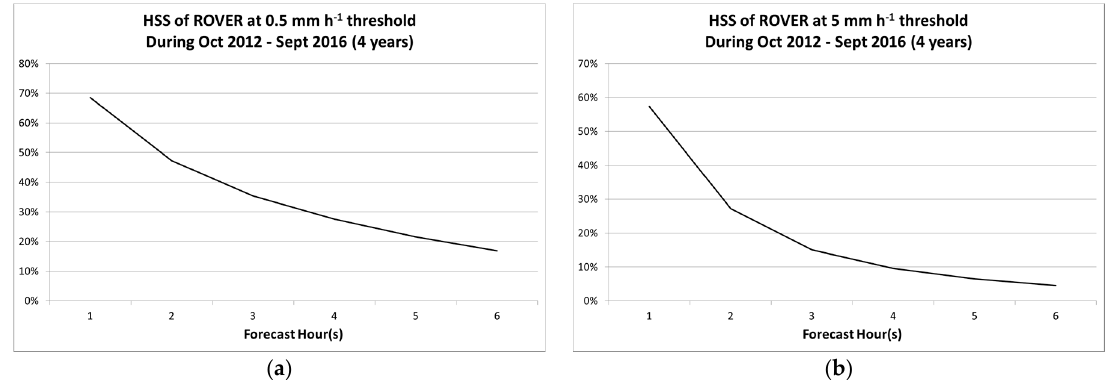
Figure 12. HSS of ROVER at: ( a ) 0.5 mm·h − 1 ; and ( b ) mm·h − 1 thresholds based on four years of data.